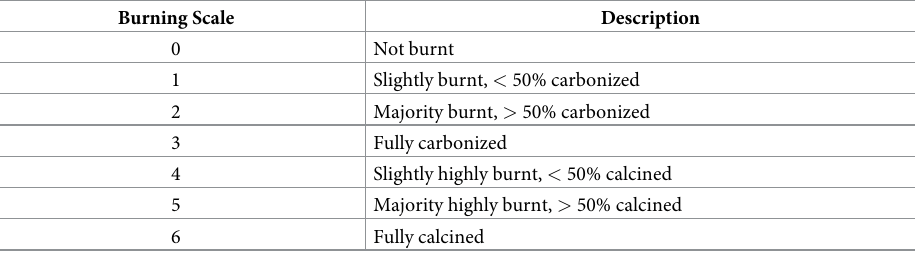
Table 1. Burning intensity scale based on macroscopic visual qualities following Stiner et al.